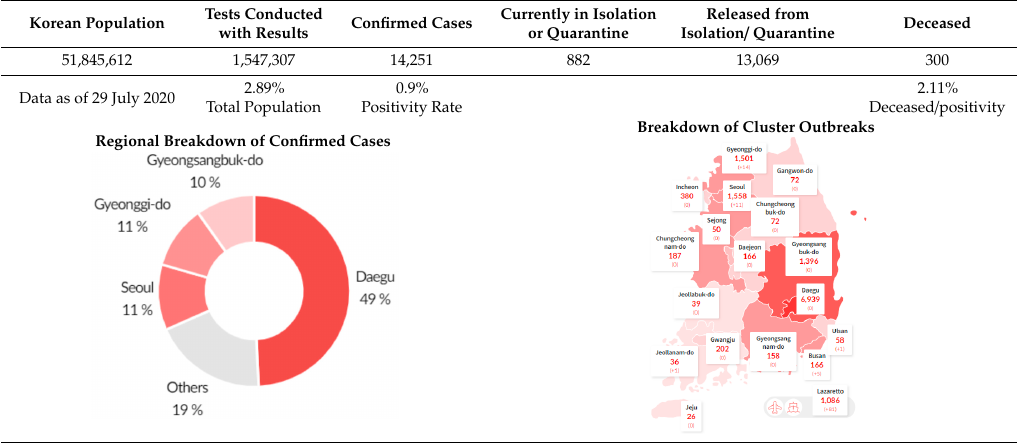
Table 1. Cases and Testing in Korea as of July 29, 2020, data aggregated from January 20. Korean Population